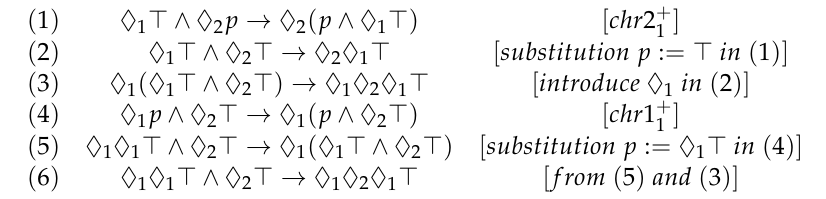
Figure 3. Additional variables p 0 , . . . , p n in chr 1 +